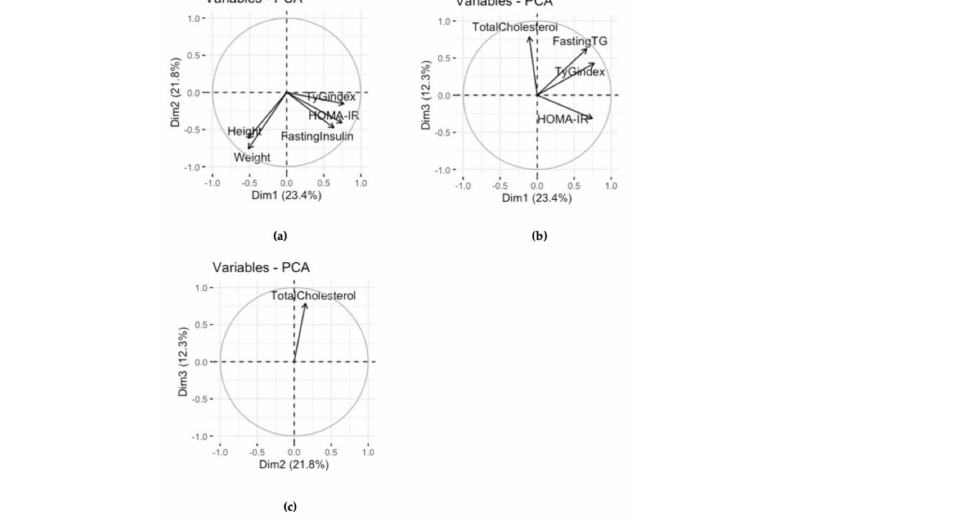
Figure 3. The panel shows the three subspaces defined by the three PCs. When the subspace defined by the two principal components describes the variables well, these are projected toward a circle unity radius, also known as the circle of correlation. As can be seen in ( a , b ), the trygliceride glucose index (TyG index), homeostasis model assessment for insulin resistance (HOMA-IR), and fasting insulin variables are all well described by the subspace defined by the PC1 and PC2; they all correlate with each other and also positively correlate with PC1. In ( c ), we can note that the subspace defined by the PC2 and PC3 describes well only the total cholesterol variable.